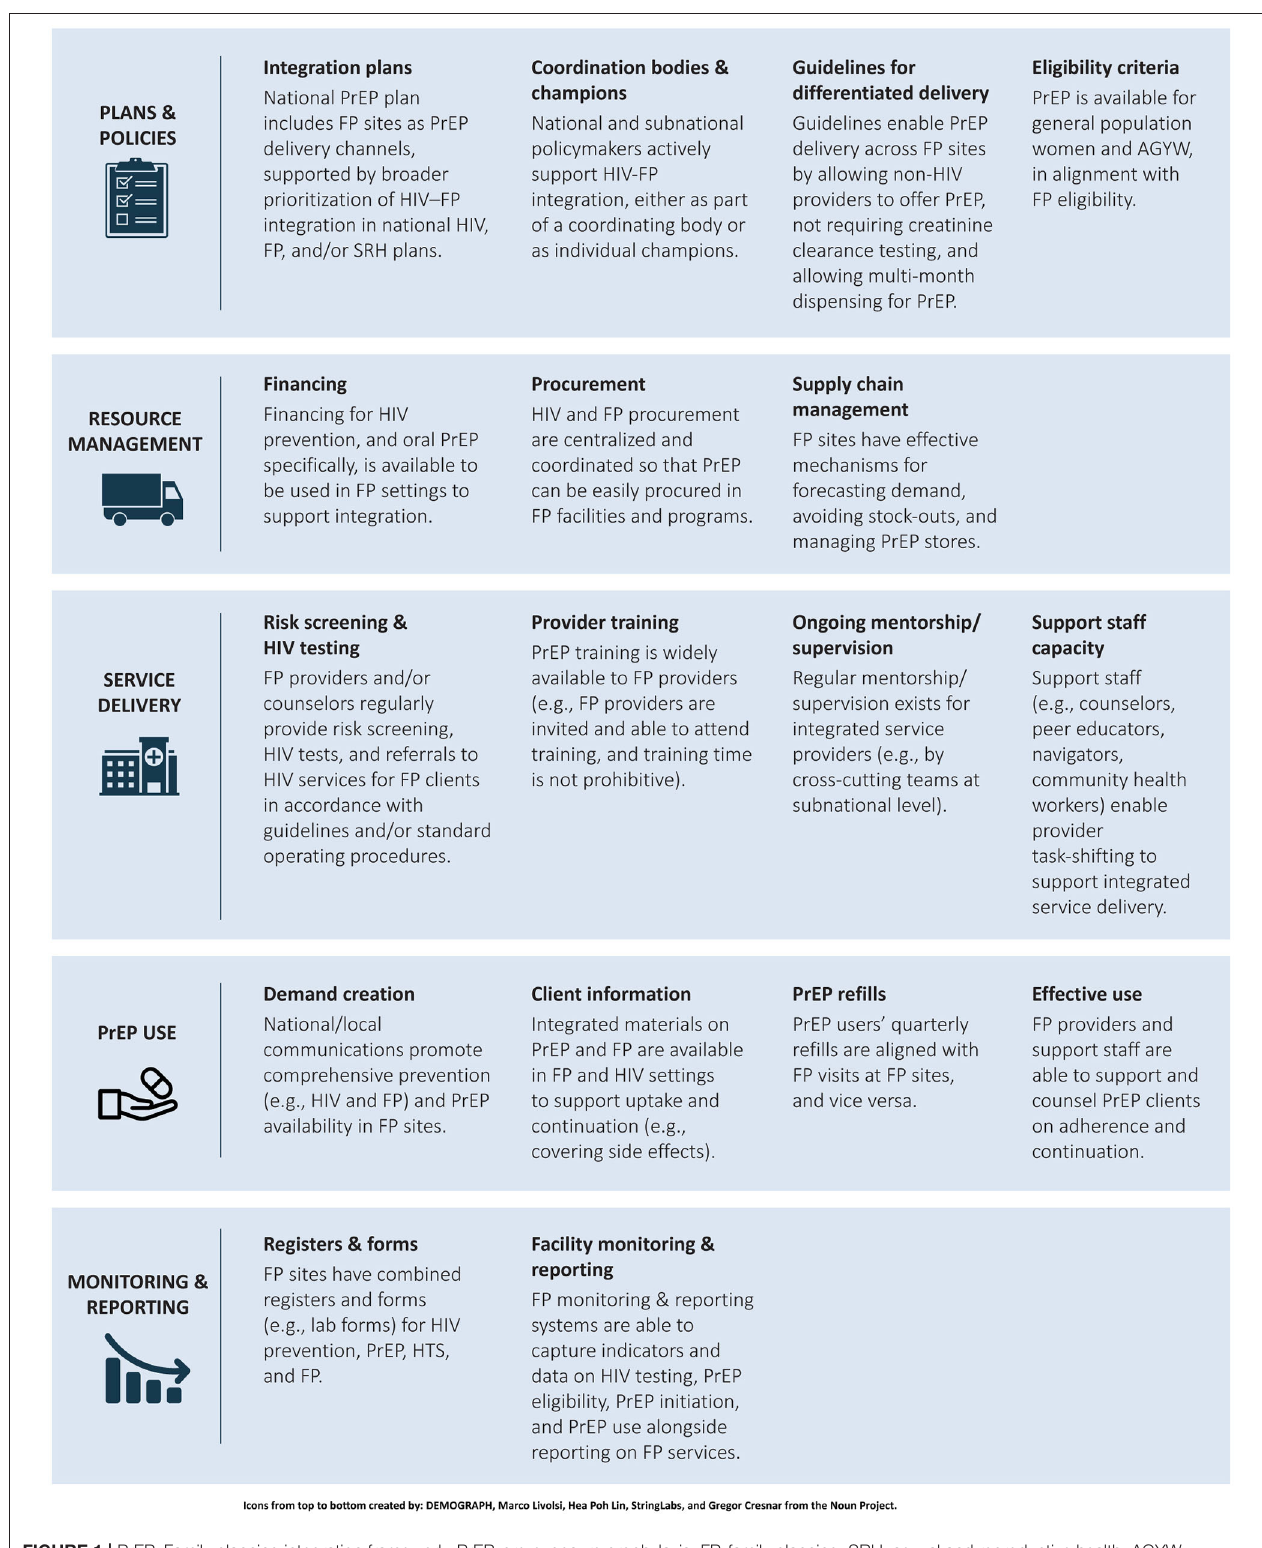
FIGURE 1 | PrEP–Family planning integration framework. PrEP, pre-exposure prophylaxis; FP, family planning; SRH, sexual and reproductive health; AGYW, adolescent girls and young women; HTS, HIV testing services.